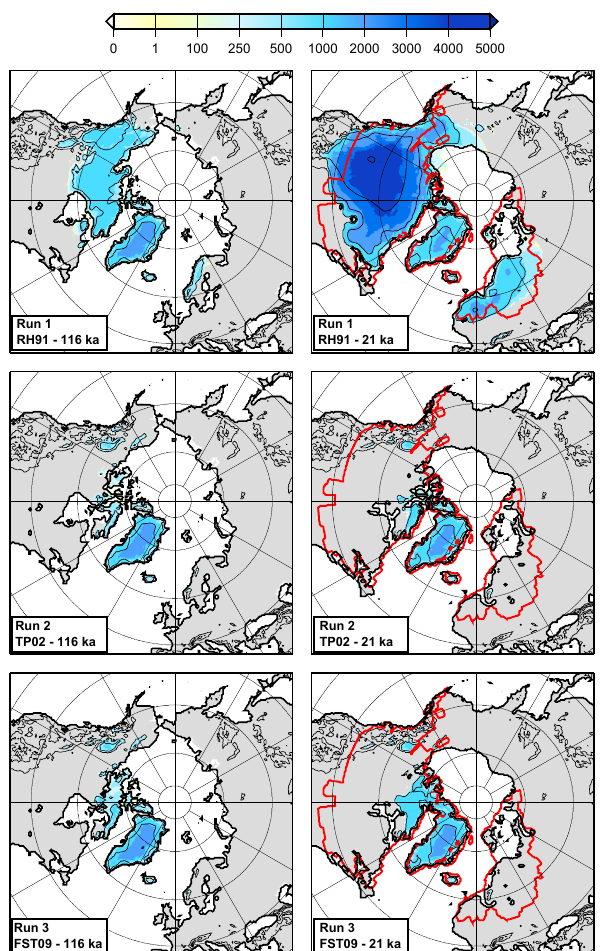
Fig. 1. Simulated ice thickness (in m) at 116ka (left panels) and 21ka (right panels) produced by the three standard fully coupled experiments with the RH91 (run 1, top panels), TP02 (run 2, mid- dle) and FST09 (run 3, bottom) PDD models. Thick black lines rep- resent the coastline and thin black lines display the iso-contours of surface elevation (from 1000 to 5000m). The thick red lines in the right panels represent the areal extent of the ICE-5G LGM ice sheets (Peltier,